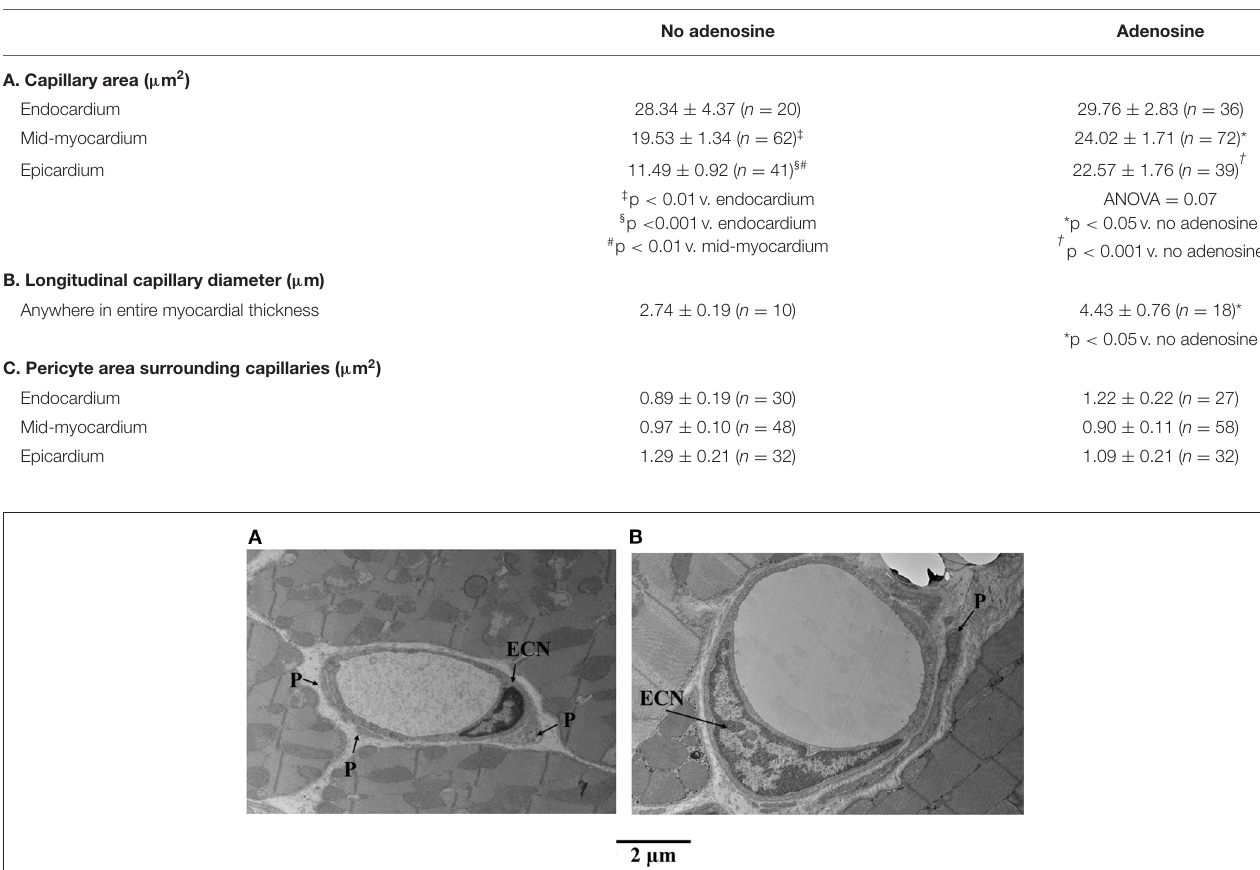
TABLE 5 | Electron microscopy results (mean ± 1SEM).